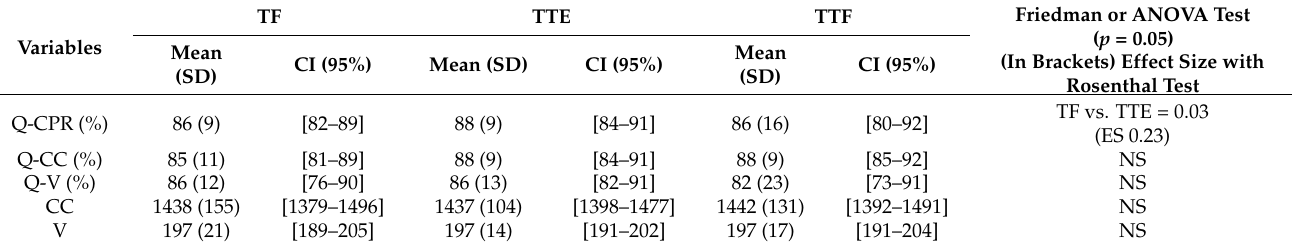
Table 1. Results of CPR test ( n = 29 pairs).